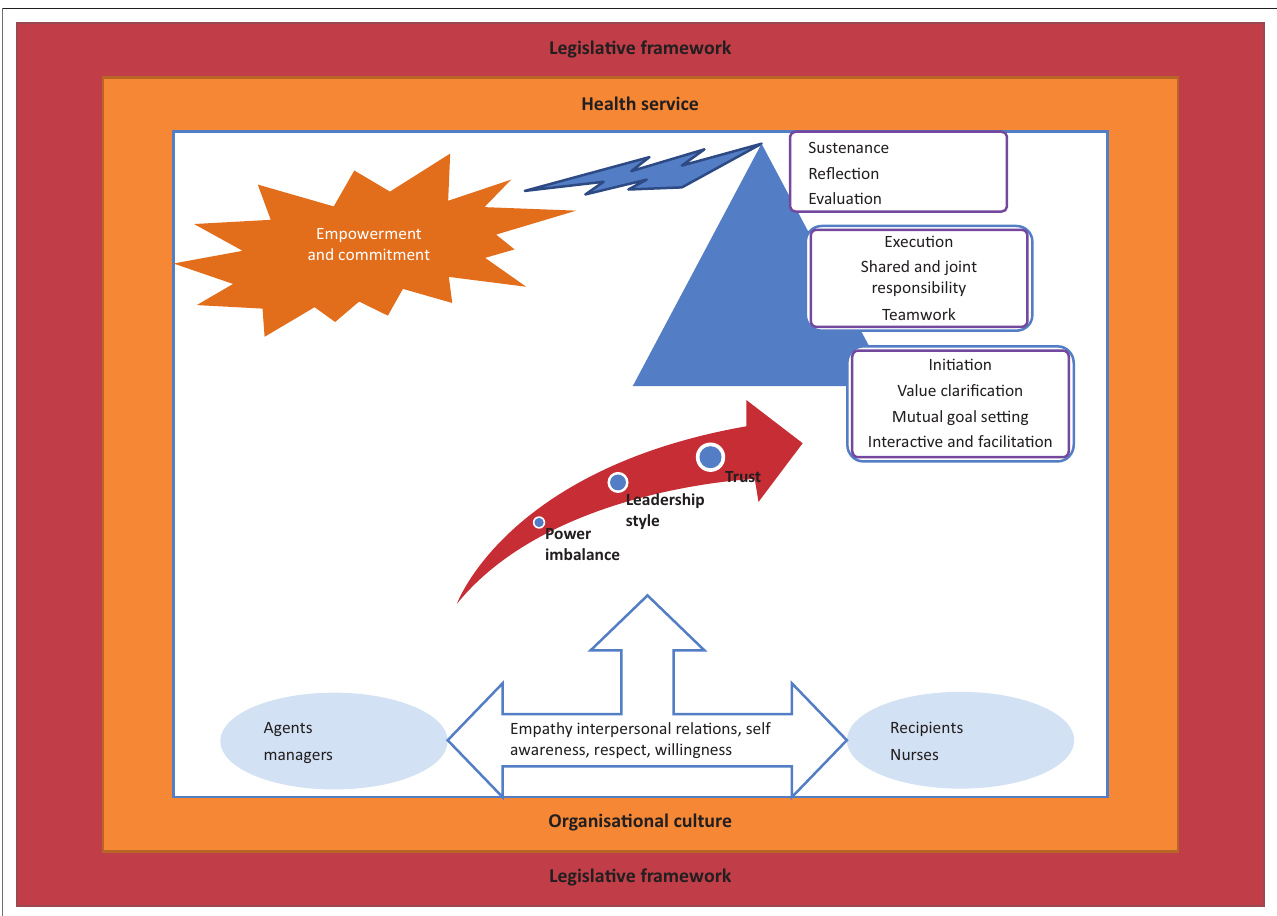
FIGURE 1: Schematic representation of the model to support nurses caring for people living with HIV and